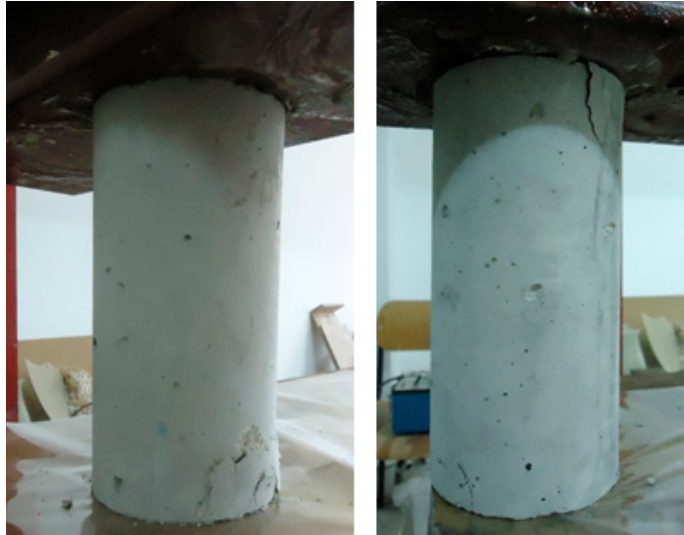
Figure 7. Details of the micro-damage due to pre-loading.